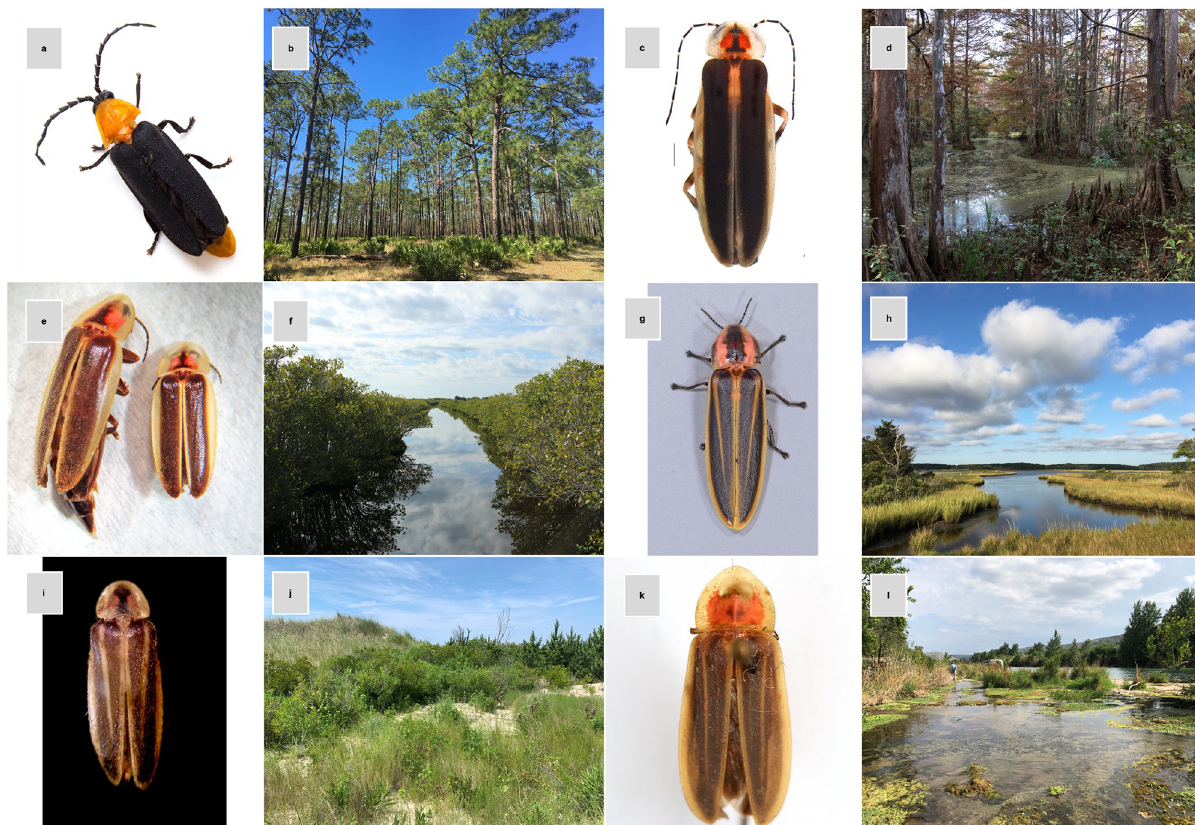
Fig 2. Threatened fireflies tend to be restricted to specialized habitats. (a) Lucidota luteicollis . Printed with permission from Brandon Woo, CC BY 4.0. (b) Characteristic upland sand scrub habitat of L . luteicollis in Florida. Reprinted from Leo Miranda/USFWS [56], CC BY 2.0. (c) Photuris walldoxeyi . Printed with permission from Luiz Silveira, CC BY 4.0. (d) Cypress swamp characteristic of P . walldoxeyi habitat. Reprinted from capt_tain Tom [57], CC BY 2.0. (e) Micronaspis floridana . Printed with permission from Lynn Faust, CC BY 4.0. (f) Coastal salt marsh typical of M . floridana in Cedar Key, Florida. Reprinted from Karen Kleis [58], CC BY 2.0. (g) Pyractomena ecostata . Printed with permission from Oliver Keller, CC BY 4.0. (h) Atlantic tidal marsh characteristic of P . ecostata habitat in Delaware. Reprinted from Andy Atzert [59], CC BY 2.0. (i) Photuris bethaniensis . Printed with permission from Christopher M. Heckscher, CC BY 4.0. (j) Interdunal swale habitat characteristic of P . bethaniensis in Delaware. Printed with permission from Emily May, CC BY 4.0. (k) Pyractomena vexillaria . Printed with permission from Mike Quinn, CC BY 4.0. (l) P . vexillaria habitat along the Devils River, Texas. Printed with permission from Ben Pfeiffer, CC BY